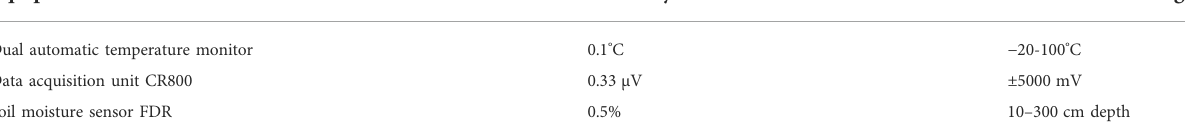
TABLE 1 The accuracy of main experimental